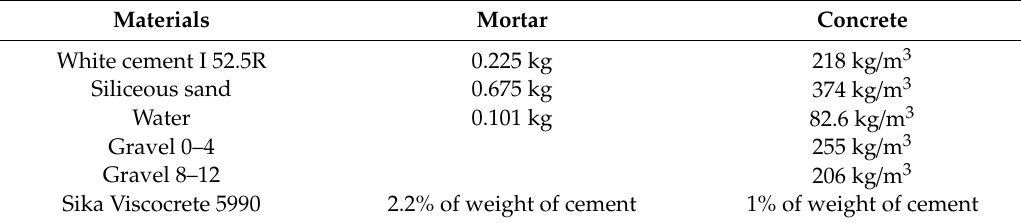
Table 1. Mix proportions of the mortar and concrete.